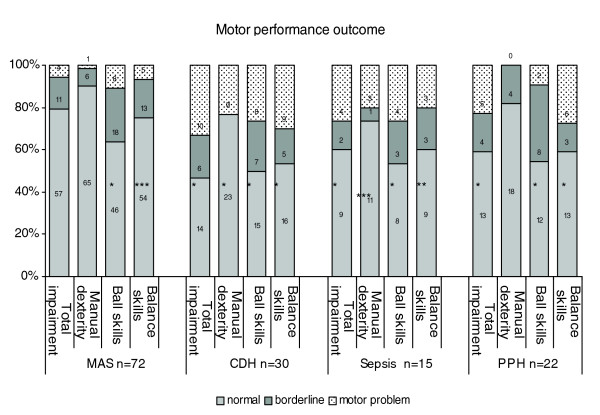
Results of movement assessment battery for all children in each primary diagnosis group. Chi-squared test (observed vs expected distribution): * P < 0.001 ** P < 0.002 *** P < 0.05. One child with pulmonary hypoplasia is not presented in the figure (all scores within the normal range). CDH = congenital diaphragmatic hernia; MAS = meconium aspiration syndrome; PPH = persistent pulmonary hypertension.